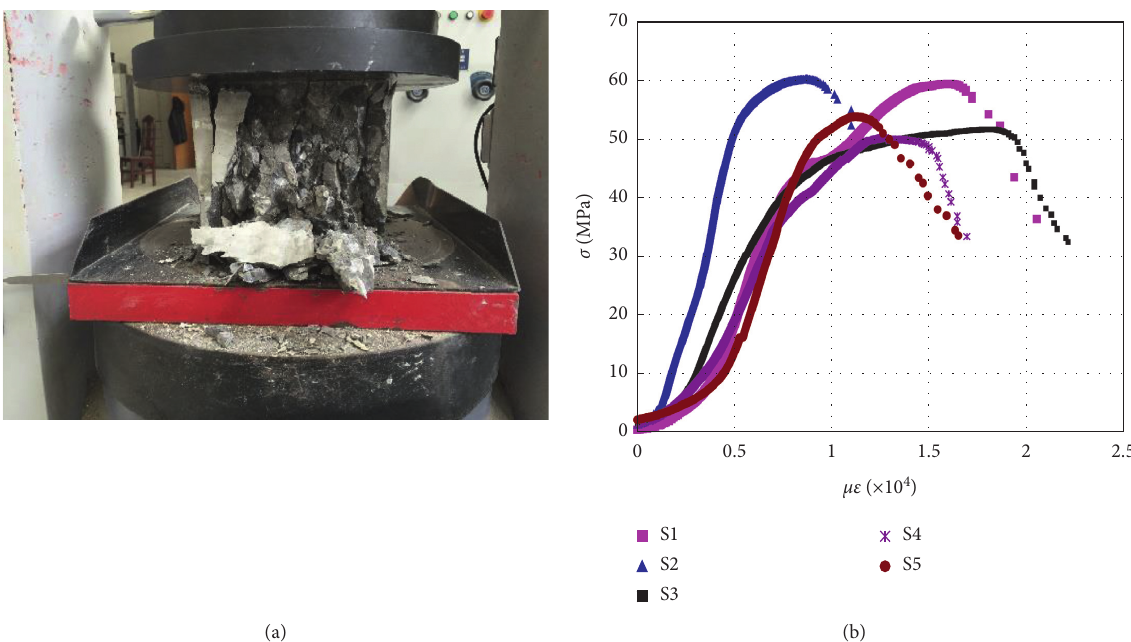
Figure 2: Uniaxial compressive strength test: (a) strength test of the cubic samples; (b) stress-strain curves.